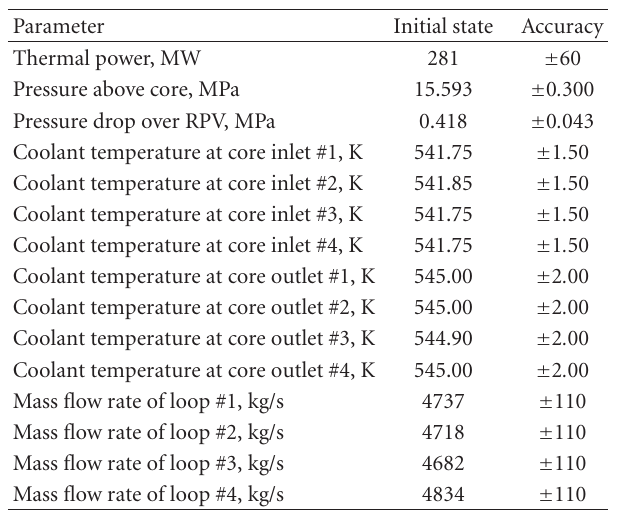
Table 2: Main parameters of the four loops before the test.